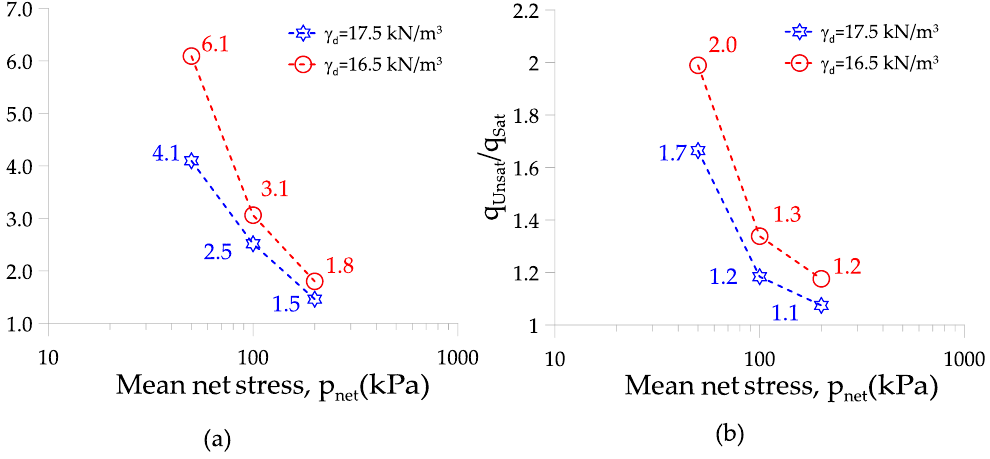
Figure 16. Stiffness and large strain deviatoric stress ratios for the unsaturated vs. saturated condi- tions of both dry densities studied. ( a ) Modulus of stiffness at 50% maximum load. ( b ) Large strain deviatoric